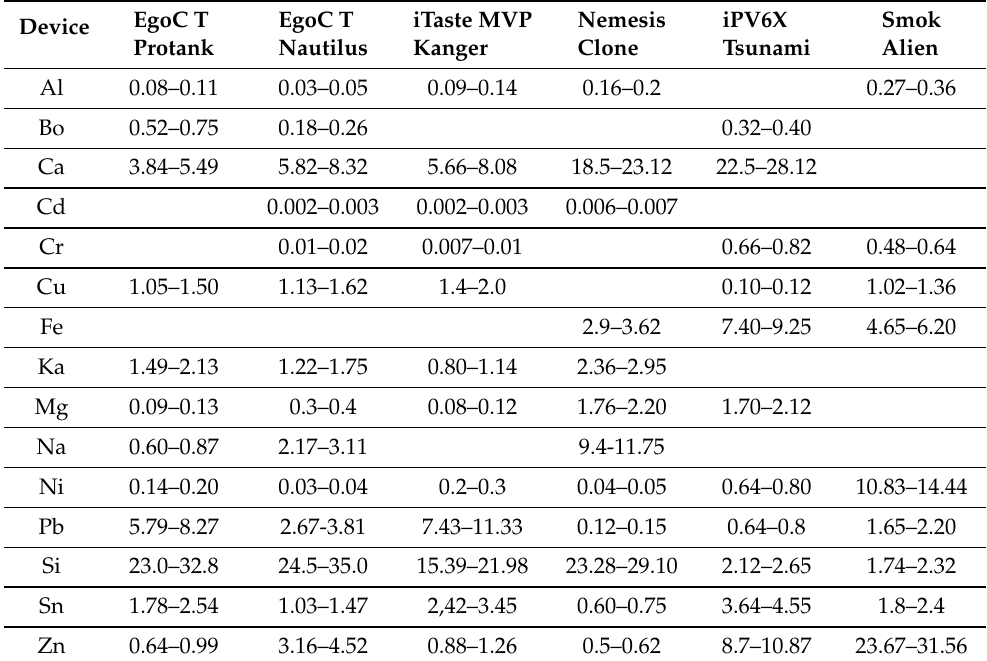
Table 10. Mass (ng) per puff for devices tested by Williams et al. in their 2019 study [18]. These values were obtained from the concentrations reported in their supplementary file (See unit conversion in our supplementary file). All metal levels are below toxicological markers given in Table